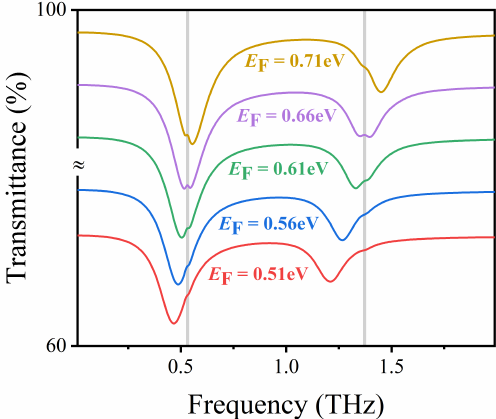
Figure 5. The transmission spectra of AIGS covered with lactose molecules at different Fermi energies under vertically incident TM waves.